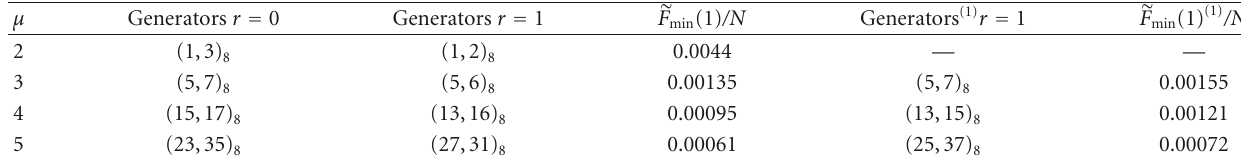
Table 2: Optimum overlays for rate 1 / (2 R ) COP-STC with BPSK, n = 2, m = 1, R = 1, in quasistatic channel. The basic code for a single transmitter is STC with the best convolutional code for the AWGN channel. Superscript (1) refers to C-STC as in [12].